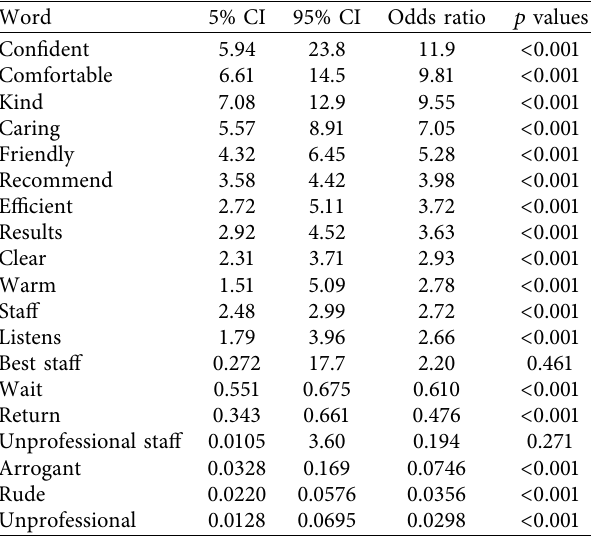
Table 8: Clinically relevant bigram frequency in best and worst reviews.